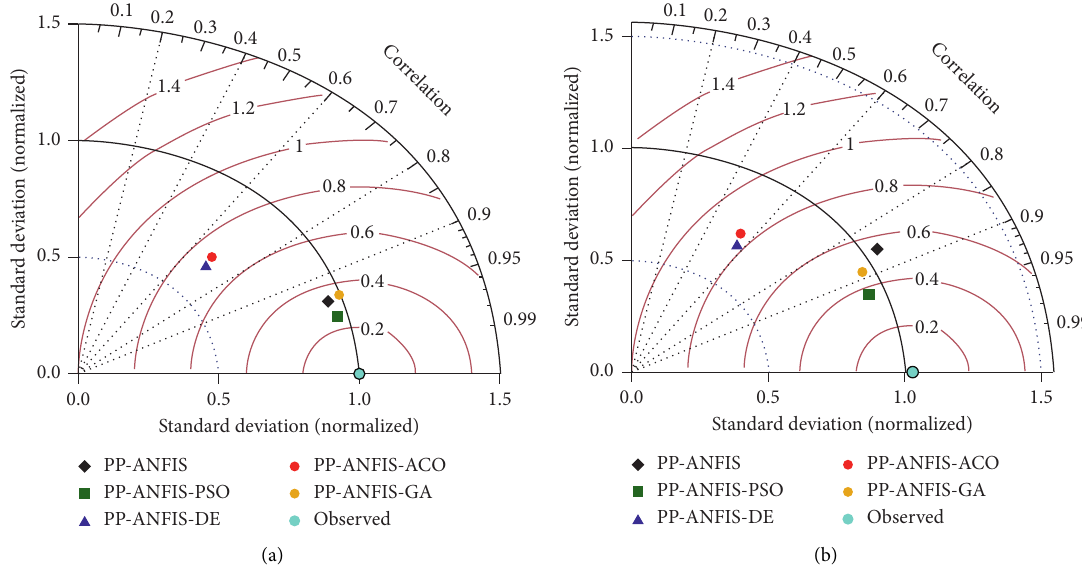
Figure 7: Normalized Taylor diagrams of predicted and observed shallow foundation settlement for the preprocessed dataset scenario: (a) training phase and (b) testing